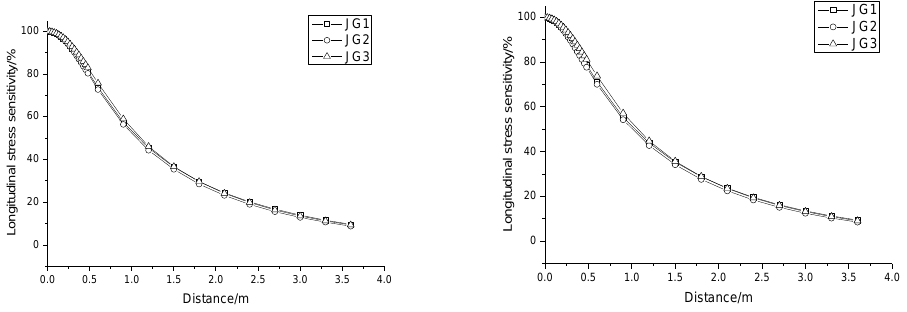
Figure 7. Longitudinal stress sensitivity of the sub-base layer bottom of three structures (unit: %).